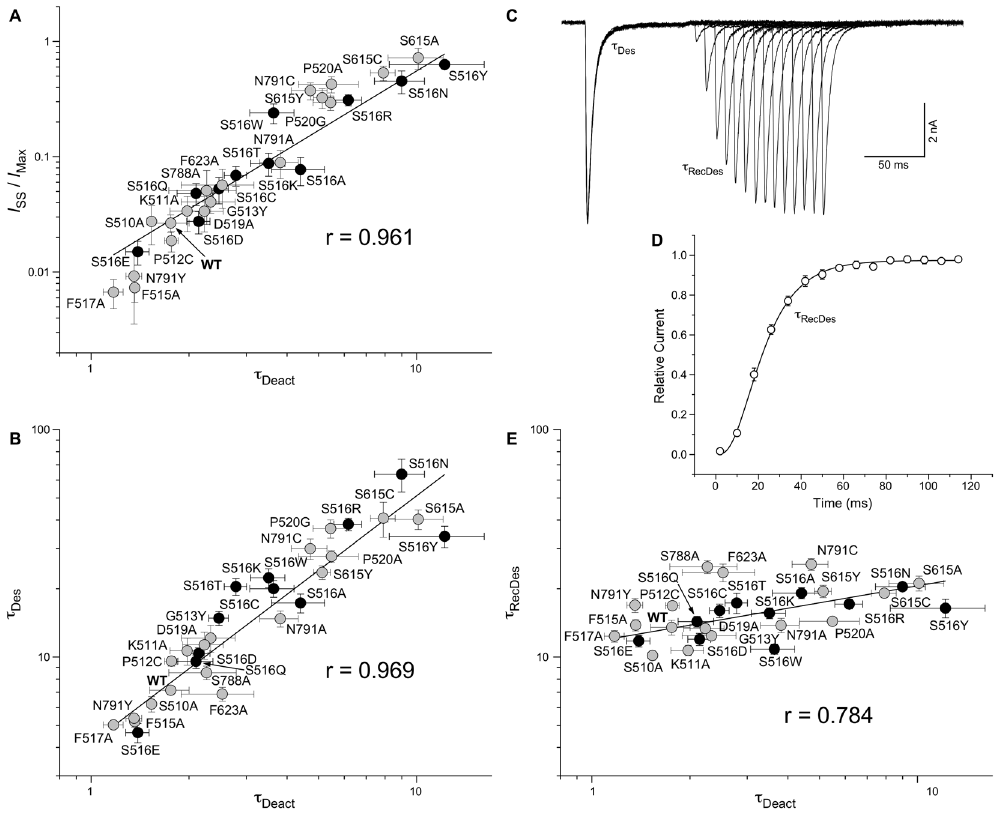
Figure 4. Correlations between gating parameters. ( A , B , E ) The fraction of non-desensitized channels, I SS / I Max ( A ), time constant of desensitization, τ Des ( B ), and time constant of recovery from desensitization, τ RecDes ( E ), plotted against the time constant of deactivation, τ Deact . Each circle represents a mutant or wild type GluA2 receptor and labelled correspondingly. Circles representing S516 substituted mutants are black, while the other mutants and wild type receptors grey. Straight lines are linear fits for the entire pool of receptors with the Pearson’s correlation coefficient, r, shown on each plot. ( C ) Currents recorded from a cell expressing GluA2- F517A using a two-pulse protocol, in which an initial application of 3 mM Glu was made to produce steady- state desensitization and was repeated after allowing the channels to recover from desensitization for different length of time. The envelope of the peak currents evoked by the series of the second applications gives the time course of recovery from desensitization. ( D ) Mean recovery from desensitization measured for GluA2-F517A using the protocol illustrated in ( C ). The curve through the points is a fit with the Hodgkin-Huxley equation (see Methods) and the values of parameters I max = 0.974 ± 0.005, τ RecDes = 12.4 ± 0.7 ms and m = 3.55 ± 0.38 ( n = 5). Error bars represent